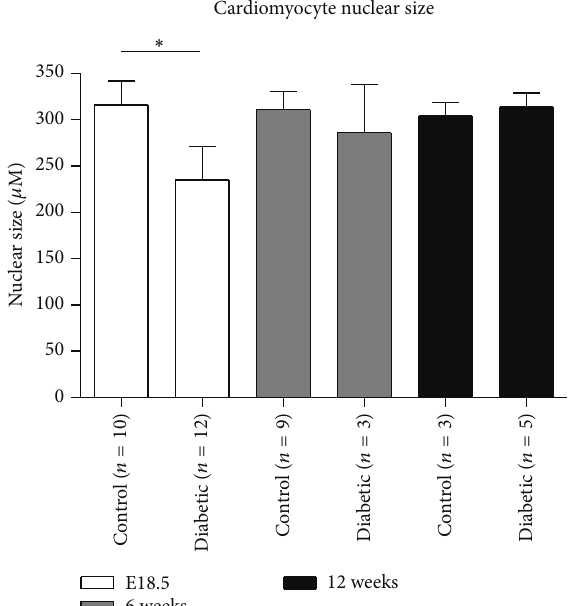
Figure 4: Comparison of the degree of collagen deposition. Cardiac tissues derived from offspring of control and diabetic groups from E18.5 (white bars), 6 weeks (grey bars), and 12 weeks (bars) of age were stained with Picrosirius red to assess the extent of collagen deposition. Slides were digitally scanned and a positive pixel count algorithm was used to automatically quantify the area occupied by the dark pink stain colors representing collagen. The collagen volume fraction was calculated and is presented. ∗ 𝑃 < 0.05